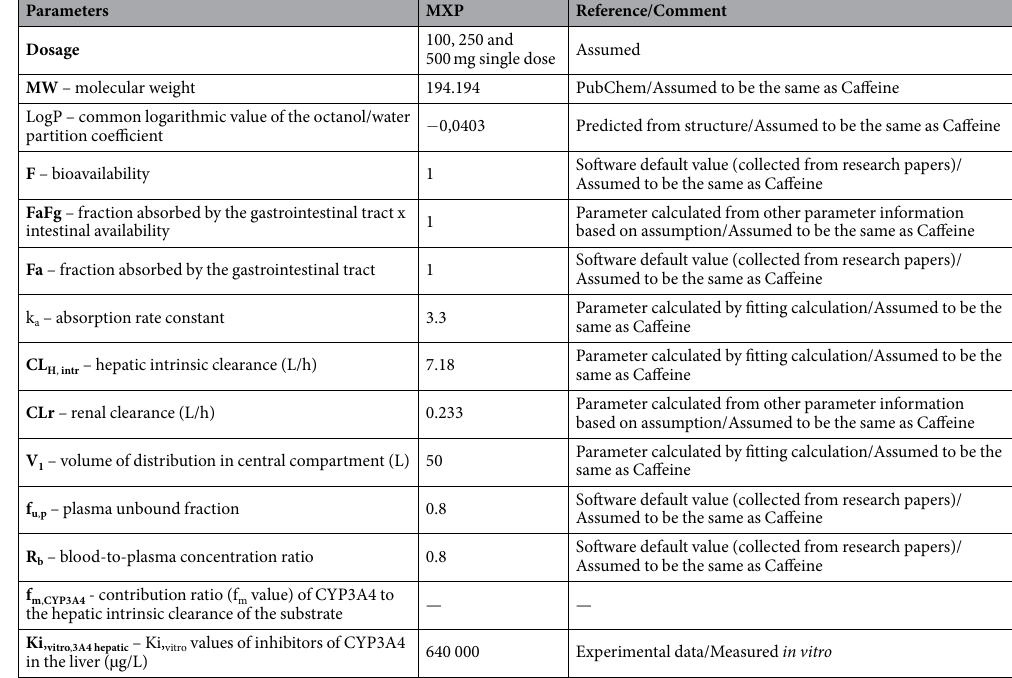
Table 4. Summary of physicochemical and pharmacokinetic parameters of methylxanthines isolated form Pu-erh (MXP) used for DDI